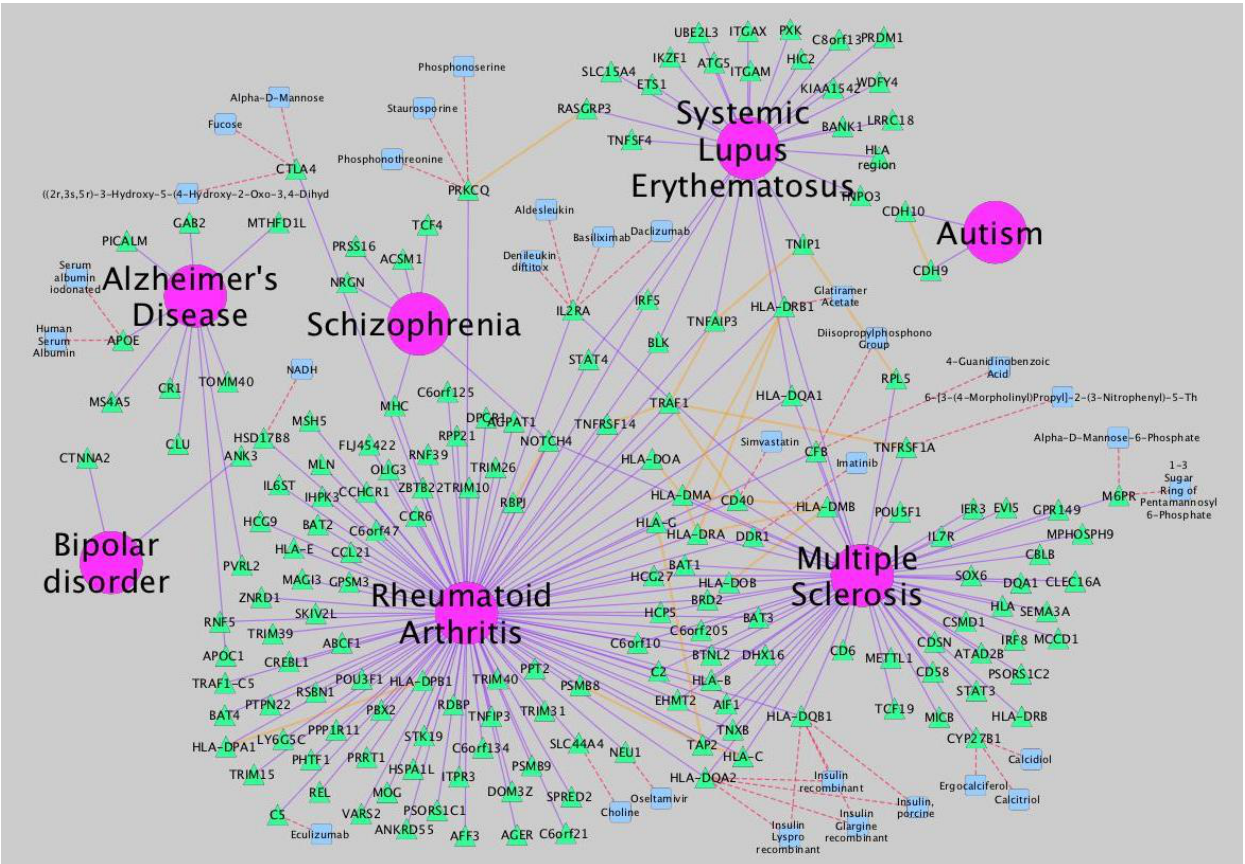
Figure 3. Network analysis of neurological disorders and related diseases using iCTNet [9]. Data to build the network is also provided by iCTNet. Several types of relationships (arcs) are represented: gene-disease association (purple), protein interaction among associated genes and select drug target interactions (red) and protein-protein interactions (orange). Node types are identified by shape and color: diseases (pink circle), genes (green triangle) and therapeutic drugs (blue